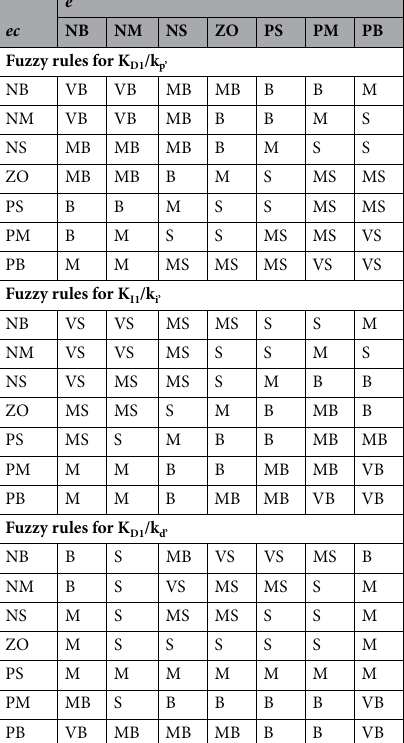
Table 2. Fuzzy rules for different output variables of FLS1 /